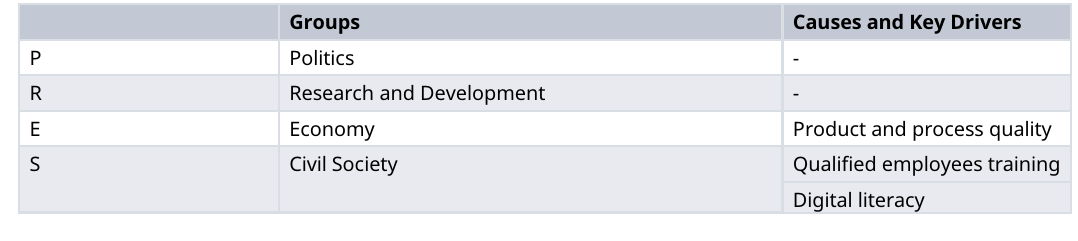
Table 4. Groups of stakeholders and assigned causes and drivers according to the “ Münchner Kreis ” 24 and Thierstein. 21